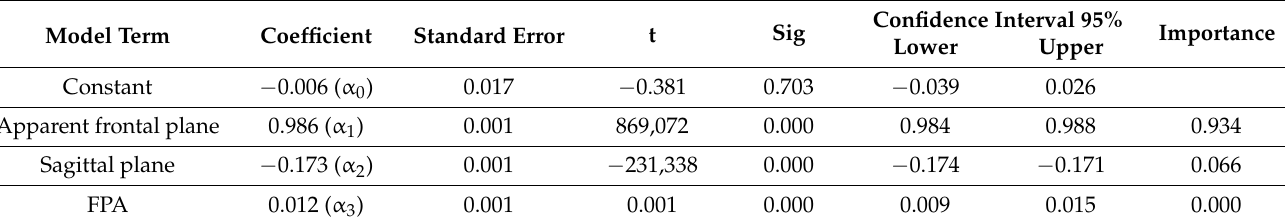
Table 1. Results of regression Model